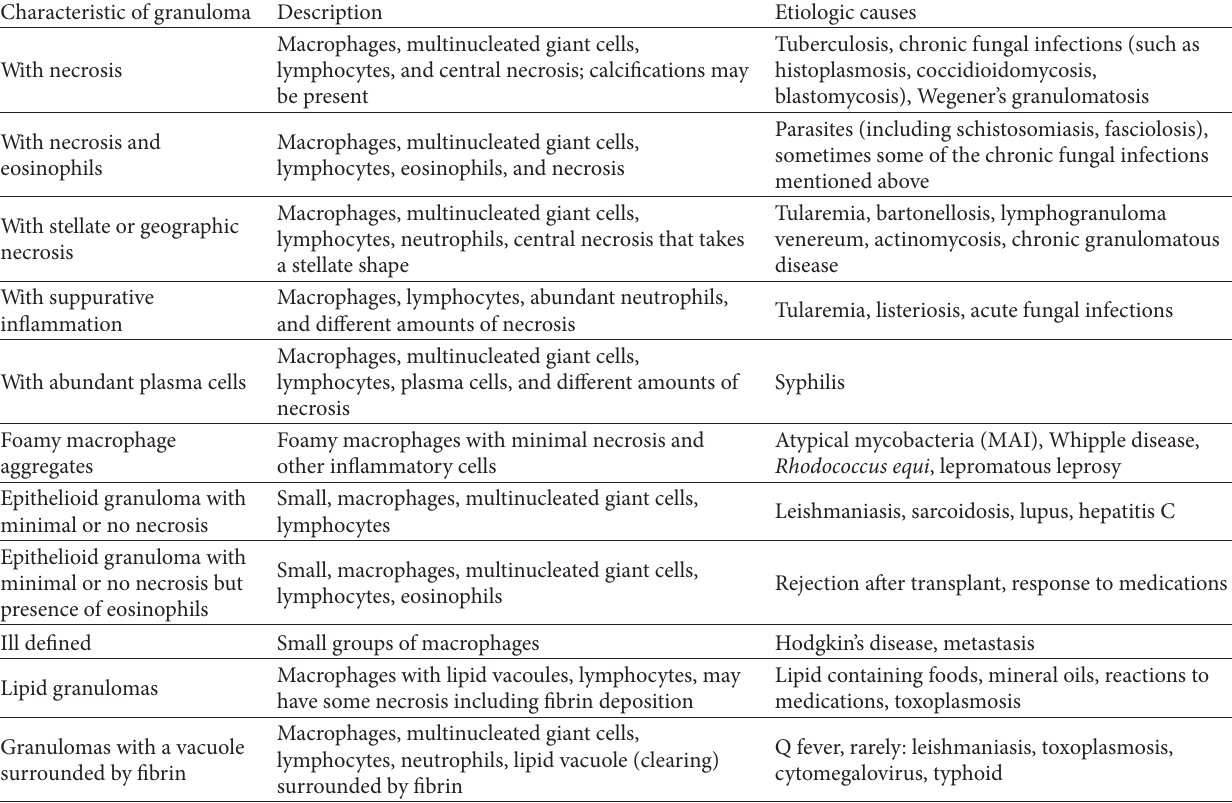
T 1: Etiologic causes of granulomas depending on the histopathologic